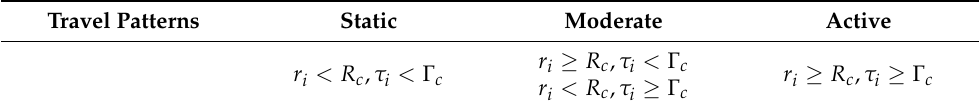
Table 1. Stratification of individuals’ travel patterns. Travel Patterns